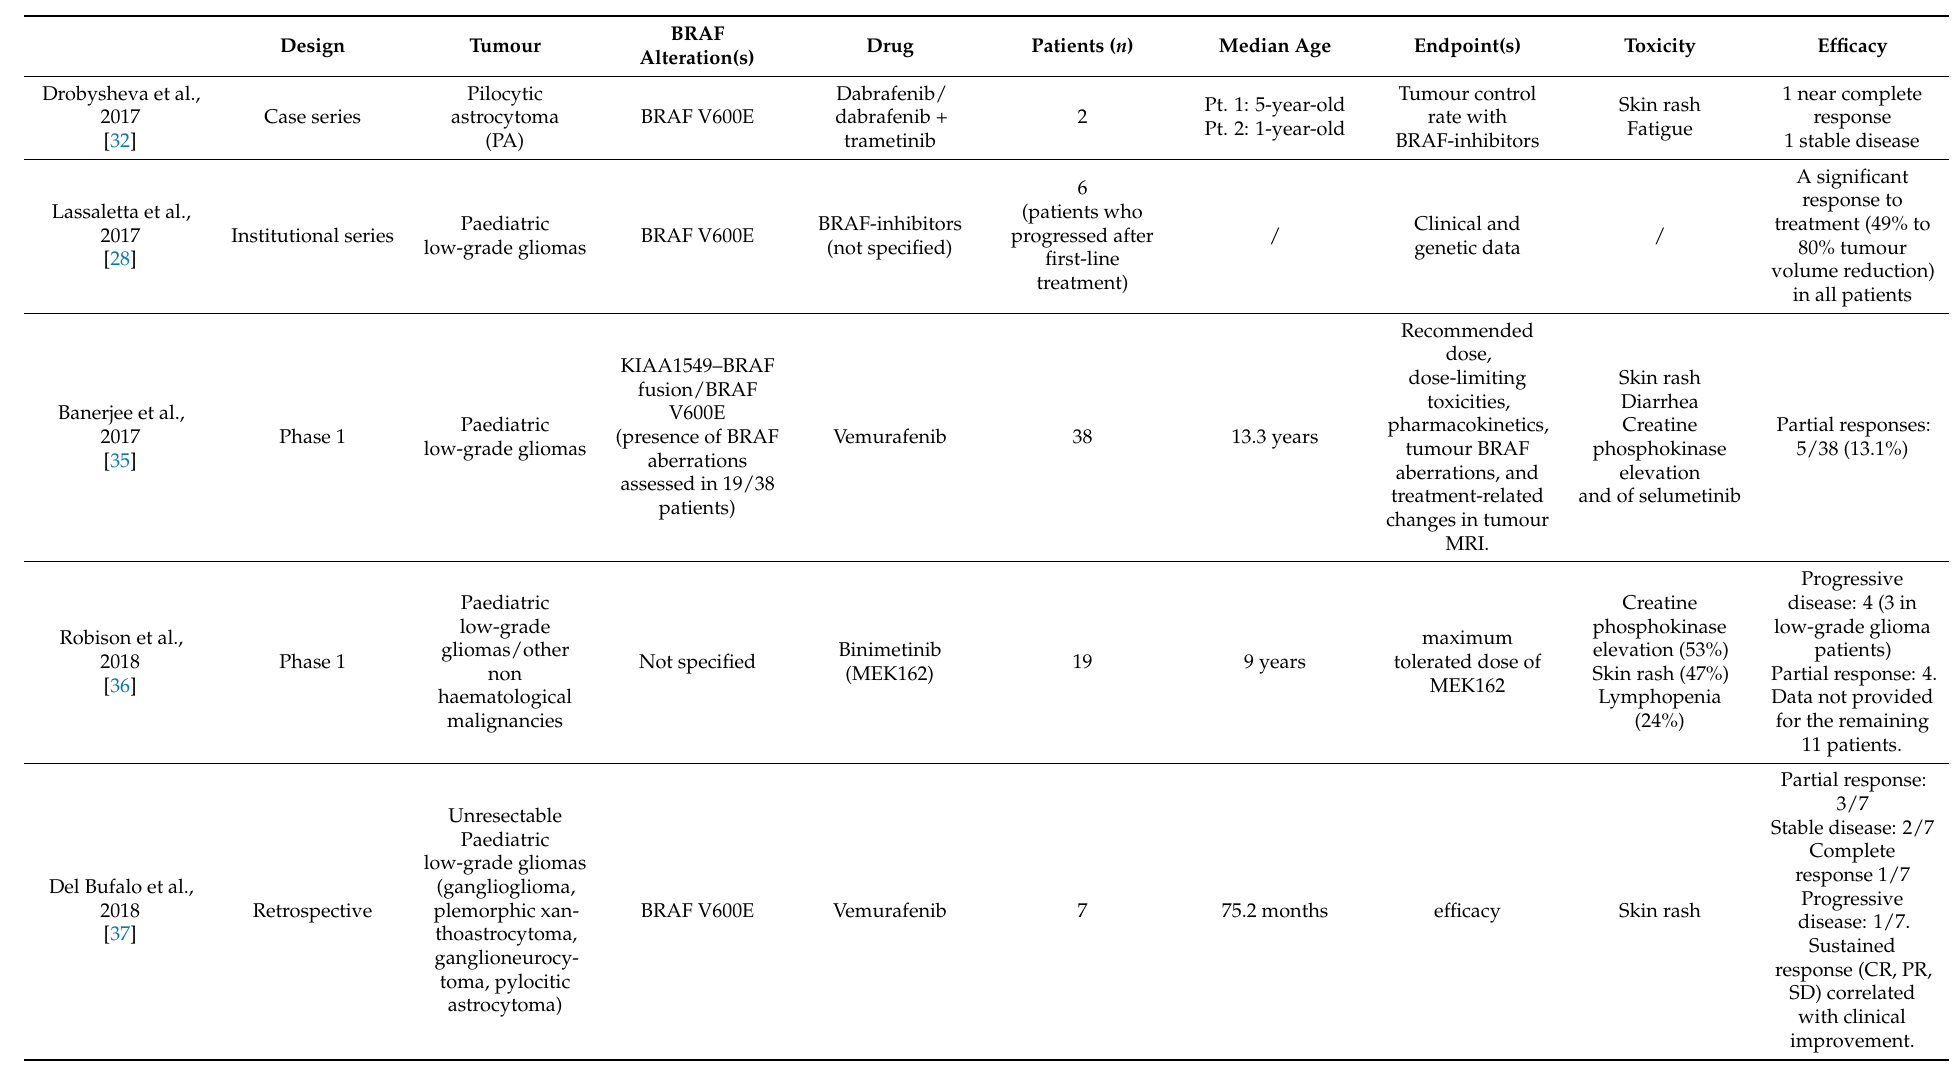
Table 3. Main studies investigating the role of BRAF inhibitors in BRAF-altered primary brain tumours (predominantly harbouring BRAF V600E